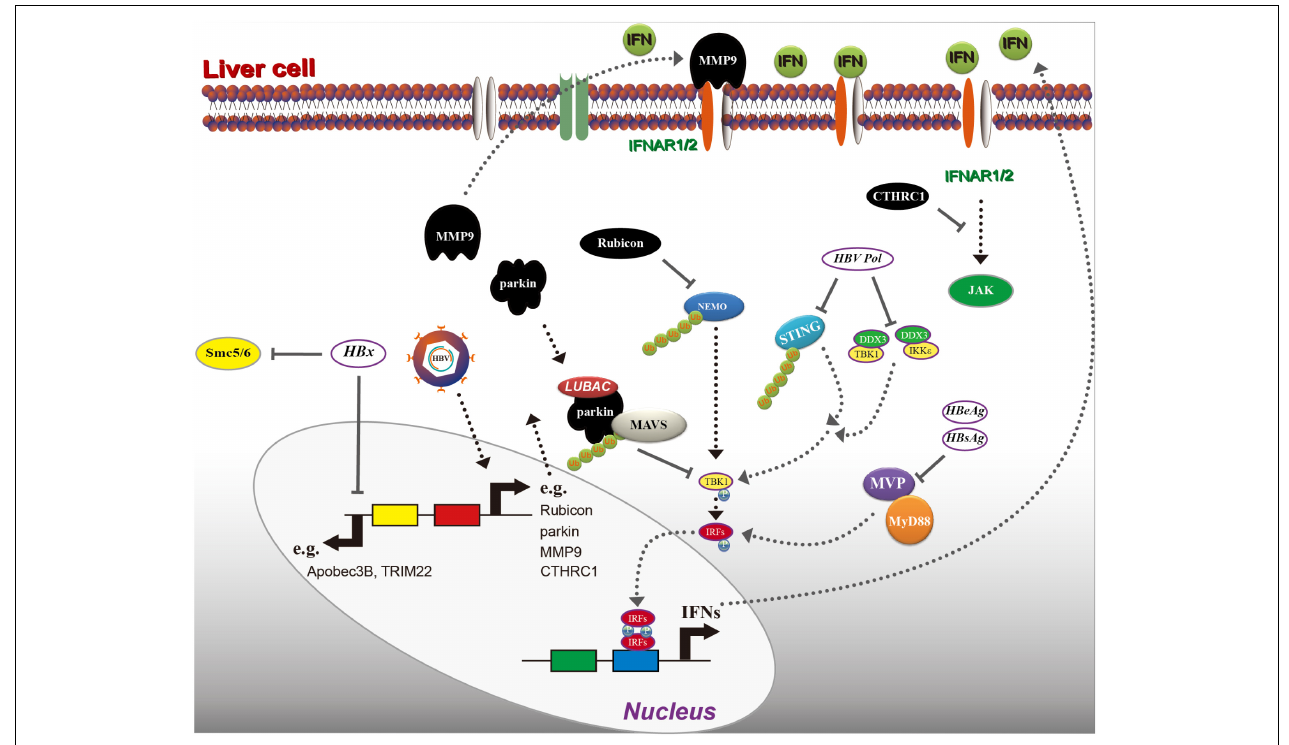
FIGURE 4 | Hepatitis B virus interrupts interferon (IFN) signaling. As indicated, HBV induces several host factors, including rubicon, parkin, MMP9, and CTHRC1. These proteins inhibit IFN production in a different mechanism, and HBV proteins including HBx, Pol (polymerase), HBsAg, and HBeAg can also block IFN induction or directly inhibit ISG induction. Please see the text for details. MVP, major vault protein; MMP9, matrix metalloproteinase 9; NEMO, nuclear factor- κ B essential modulator; LUBAC, linear ubiquitin assembly complex; RIG-I, retinoic acid inducible gene I; MAVS, mitochondrial antiviral-signaling